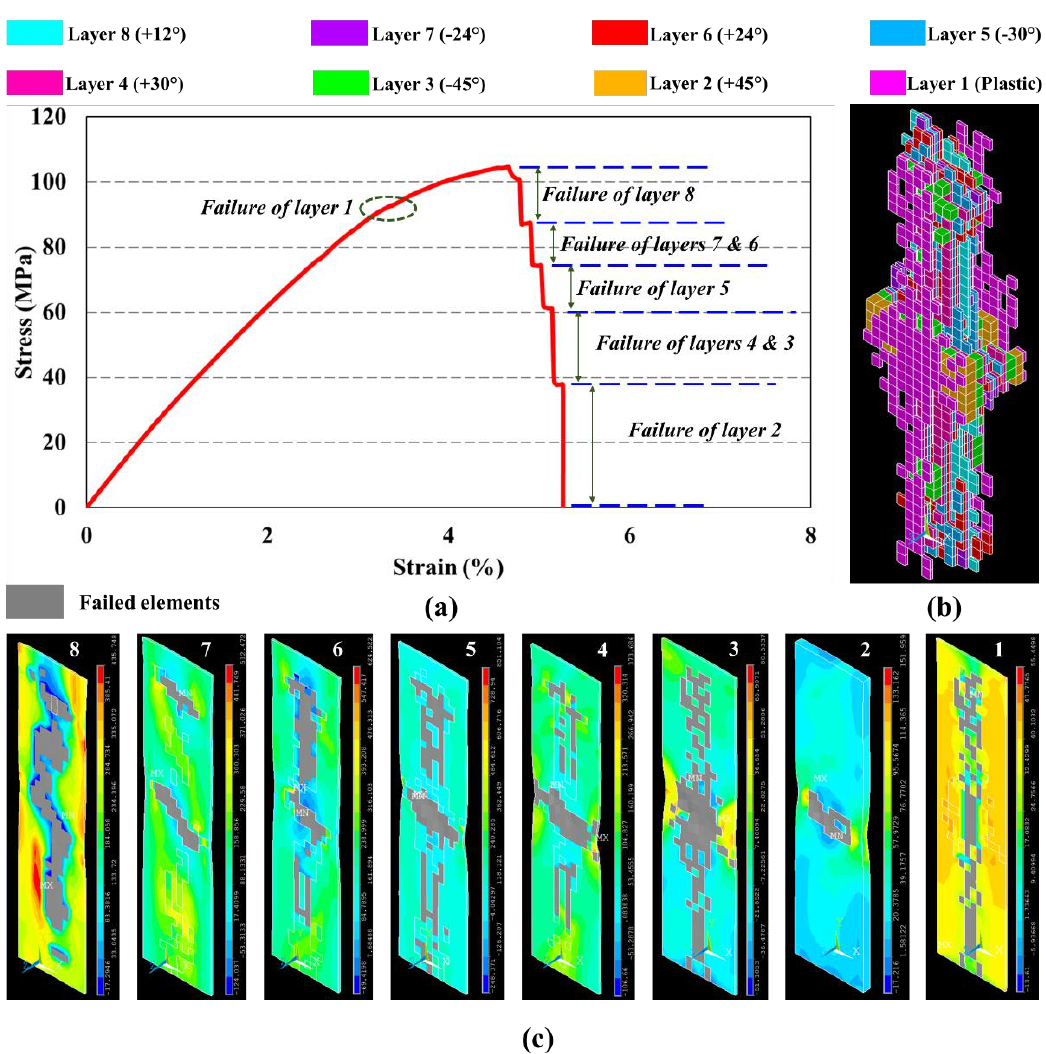
Figure 13. ( a ) Progressive failure in multi-angled 3D-printed GFRP composite, ( b ) all failed elements in composite, and ( c ) failure in each layer after corresponding drops.